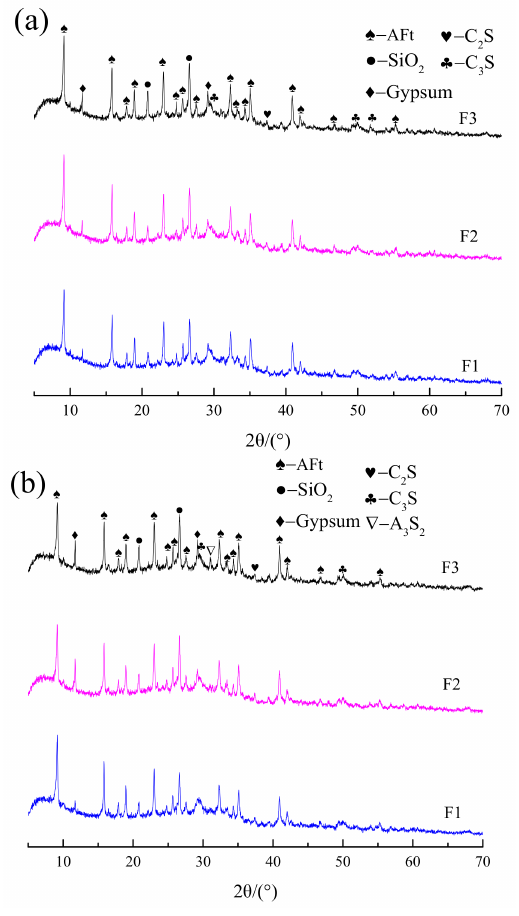
Figure 3. XRD spectra of F1, F2, and F3 groups at 7 d and 28 d: ( a ) 7 d, ( b ) 28